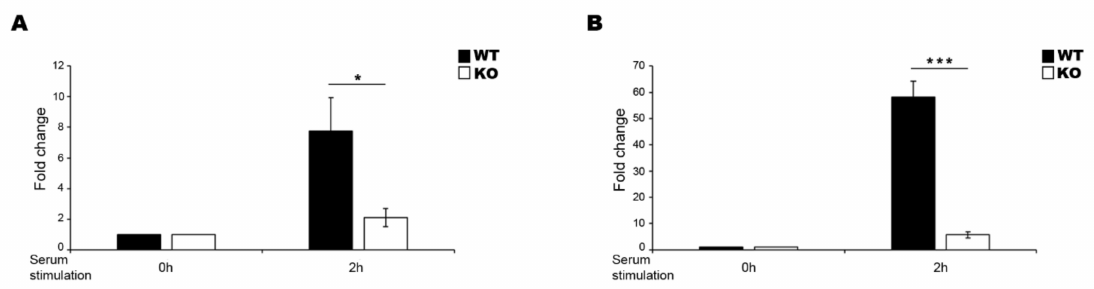
Figure 2. E ff ect of serum stimulation on EGR1 WT and KO cells. LINC00473 expression level change in N-enriched SH-SY5Y EGR1 WT and KO cells ( A ) and in HEK293T EGR1 WT and KO cells ( B ) after 2 h of serum stimulation. The sample at time 0 h was used as the calibrator. Gene expression level was normalized to the reference transcript GAPDH and calculated by the 2 − ∆∆ Ct method. The results from independent biological replicates are expressed as mean of fold change ± SEM. Significance of di ff erence (* p ≤ 0.05, *** p ≤ 0.0001) is